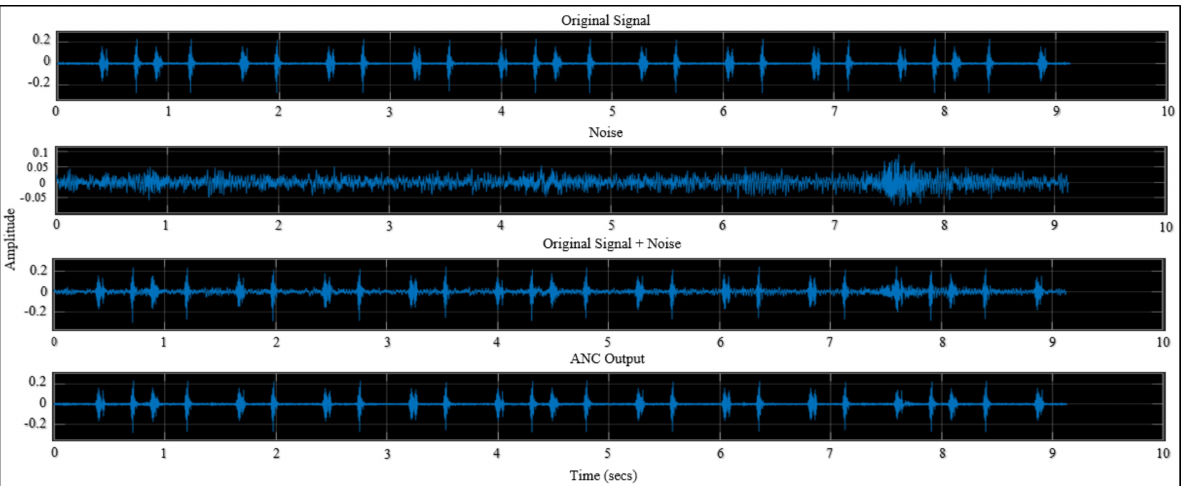
Figure 17. SIMULINK model